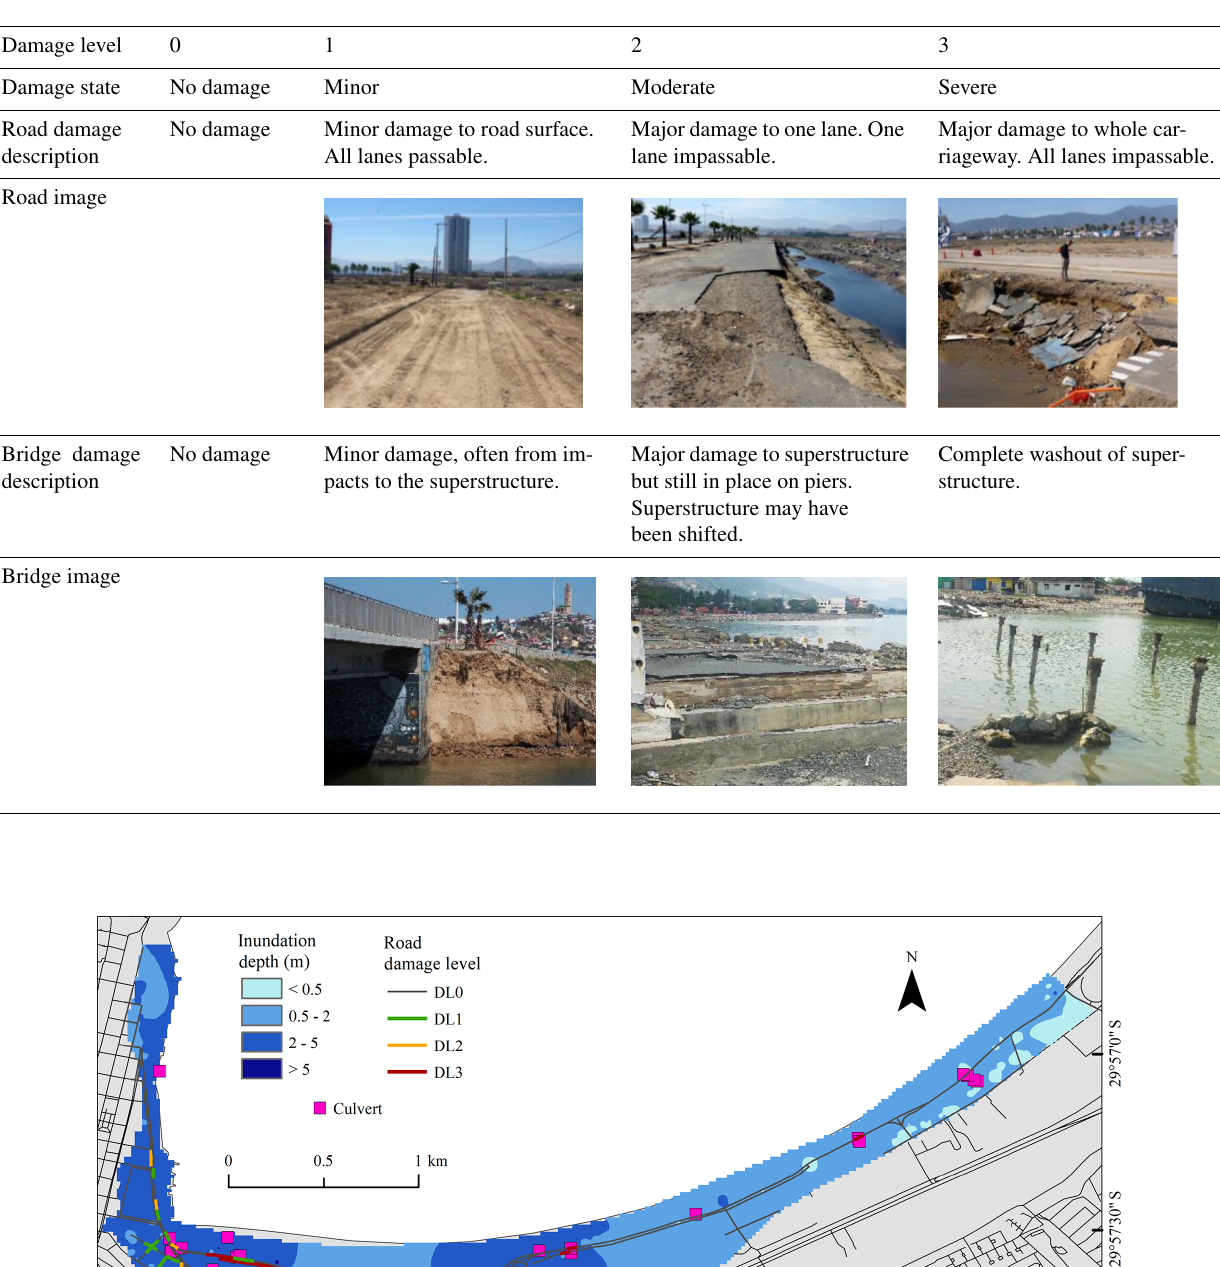
Table 1. MLIT damage classifications for roads and bridges (MLIT, 2012) and field examples of road damage levels from the 2015 Illapel earthquake and tsunami, Coquimbo, Chile, and equivalent bridge examples from the 2018 Sulawesi earthquake and tsunami, Indonesia.